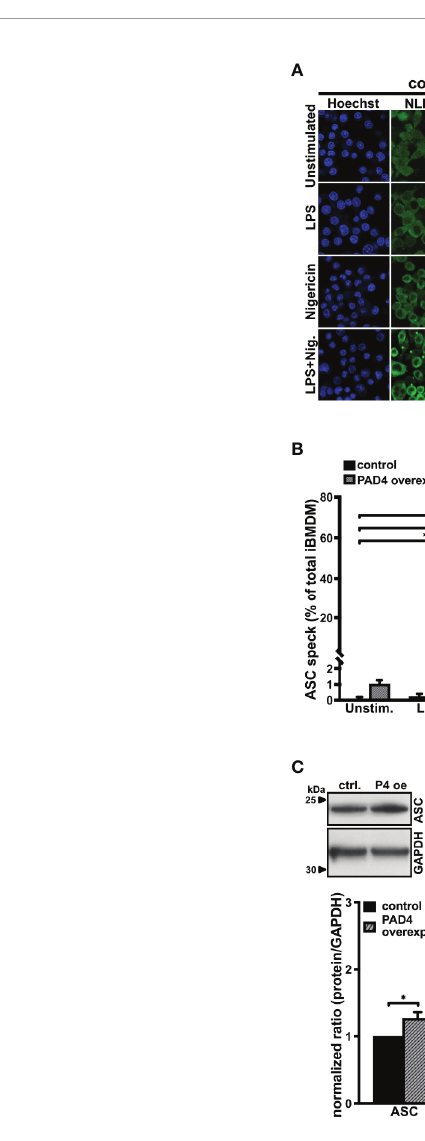
FIGURE 3 | PAD4 overexpression leads to priming-independent ASC speck formation and IL-1ß secretion with an increase in ASC and NLRP3 protein levels in immortalized bone marrow – derived murine macrophages (A) Confocal microscopy images of immunostained native mouse immortalized bone marrow – derived macrophages (iBMDM; control, left panel) and PAD4 overexpressing iBMDM (right panel) in the absence (unstimulated) or presence of LPS only (1 µg/mL), nigericin only (15 µM), or LPS and nigericin (15 µM, 0.5 hours). Blue, DNA (Hoechst); green, NLRP3 antibody staining; grey, ASC antibody staining. Scale bar equals 5 µm. Representative of n=4 experiments. (B) Arithmetic means ± SEM (n=4) of percentage of ASC speck formation (left panel) and IL-1ß production (right panel) in native iBMDM (control, black bars) or PAD4 overexpressing iBMDM (grey shaded bars) in the absence (unstim.) or presence of LPS only (1 µg/mL), nigericin only (15 µM), or LPS (1 µg/mL) and nigericin (15 µM, 0.5 hours). ** p<0.01 and *** p<0.001. (C) Representative western blots (upper panel) and arithmetic means ± SEM (lower panel, n=4) of ASC and NLRP3 protein levels in native iBMDM (ctrl.) or PAD4 overexpressing (P4 oe) iBMDM. * p<0.05 and ** p<0.01. (D) Arithmetic means ± SEM (n=4) of relative mRNA levels in native iBMDM (control) or PAD4 overexpressing